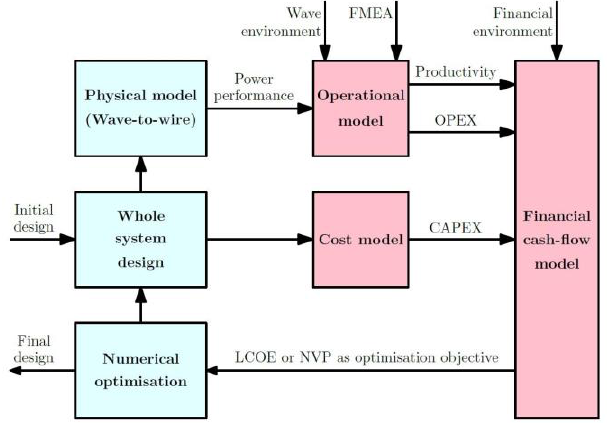
Fig. 1. Structure of the integrated techno-economic optimization software (in red the components utilised for the current